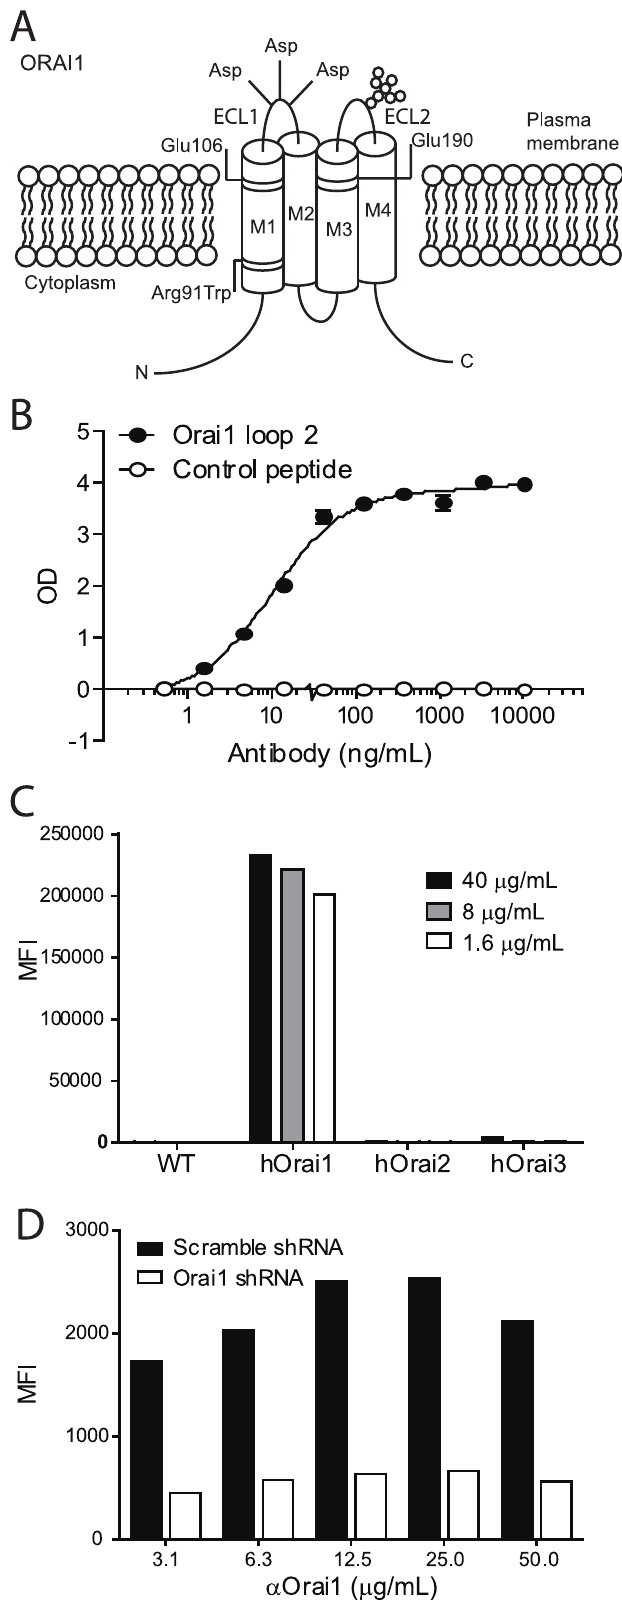
Figure 1. Generation of specific anti-human Orai1 monoclonal antibody. A ) Representation of human Orai1 tetra-membrane spanning protein with two extracellular loops of approximately 20 and 40 amino acids, respectively. B ) Titration of purified monoclonal anti-Orai1 antibody